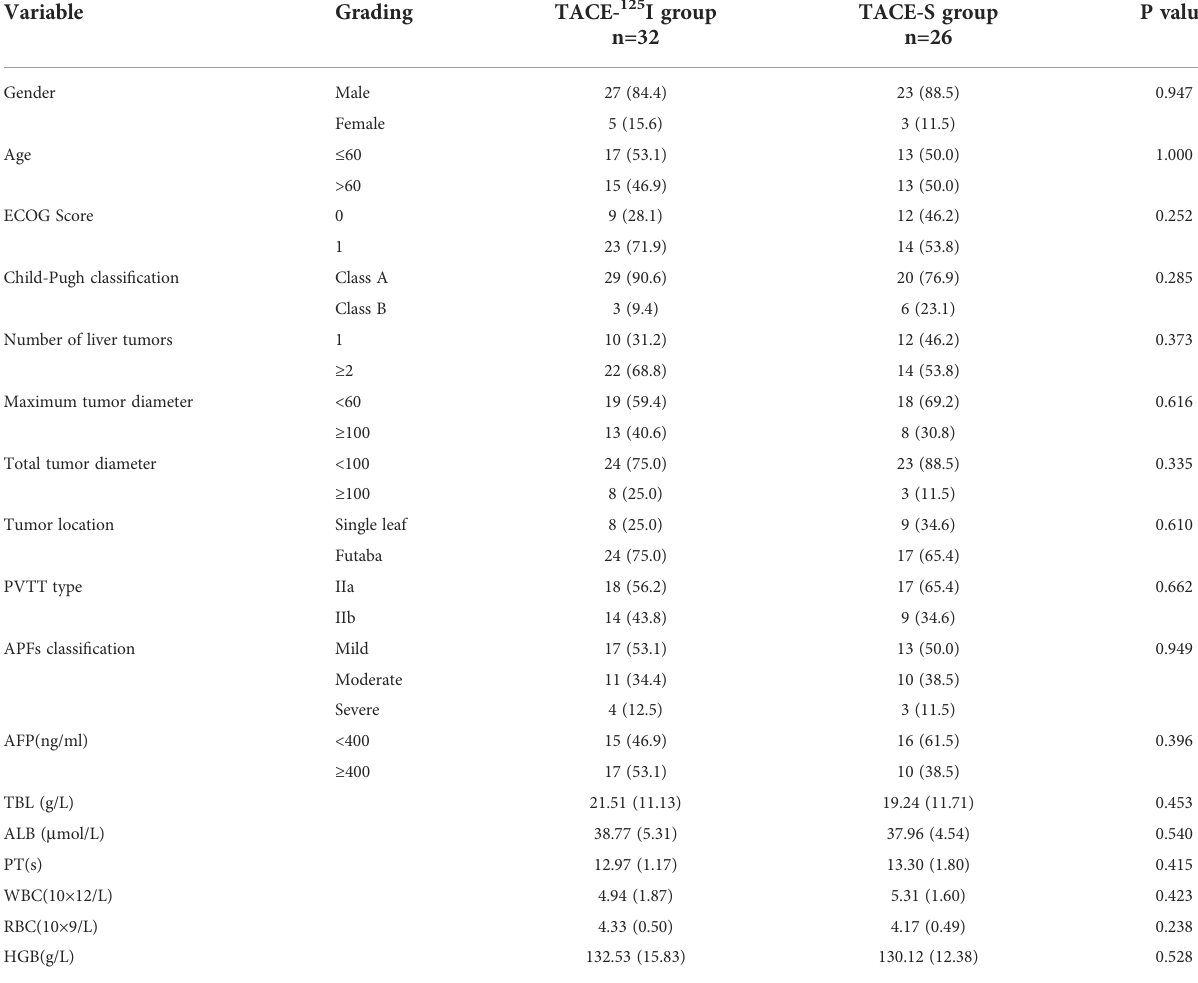
TABLE 1 Comparison of general data of patients in the TACE- 125 I group and the TACE-S group. Variable